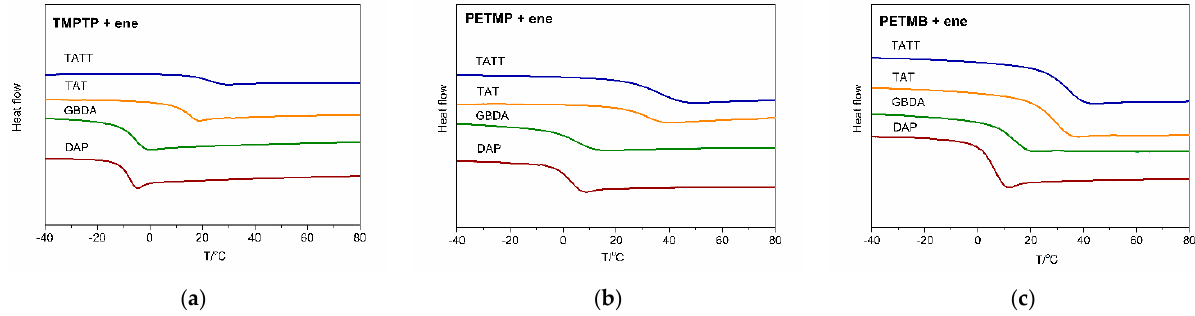
Figure 6. DSC curves of thiol–ene polymers obtained in bulk polymerization of the compositions: ( a ) TMPTP + ene, ( b ) PETMP + ene, ( c ) PETMB + ene. Used enes: DAP (red line), GBDA (green line), TAT (orange line), TATT (blue line). Table 5. Glass transition temperature of thiol–ene polymers (obtained in bulk polymerization).